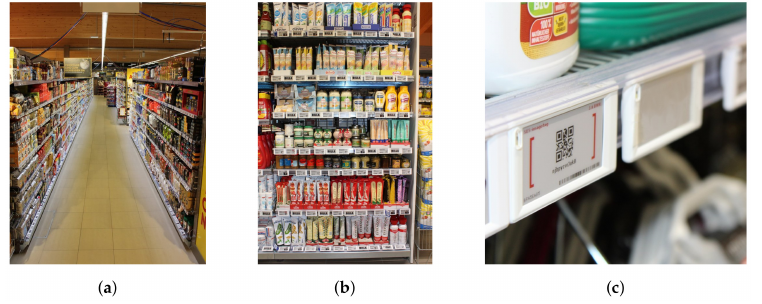
Figure 3. Grocery store test environment. ( a ) Aisle 1 with anchor 0 in the foreground. ( b ) Single shelf at x = 13.5m, y = 10m. ( c ) Transmitter node